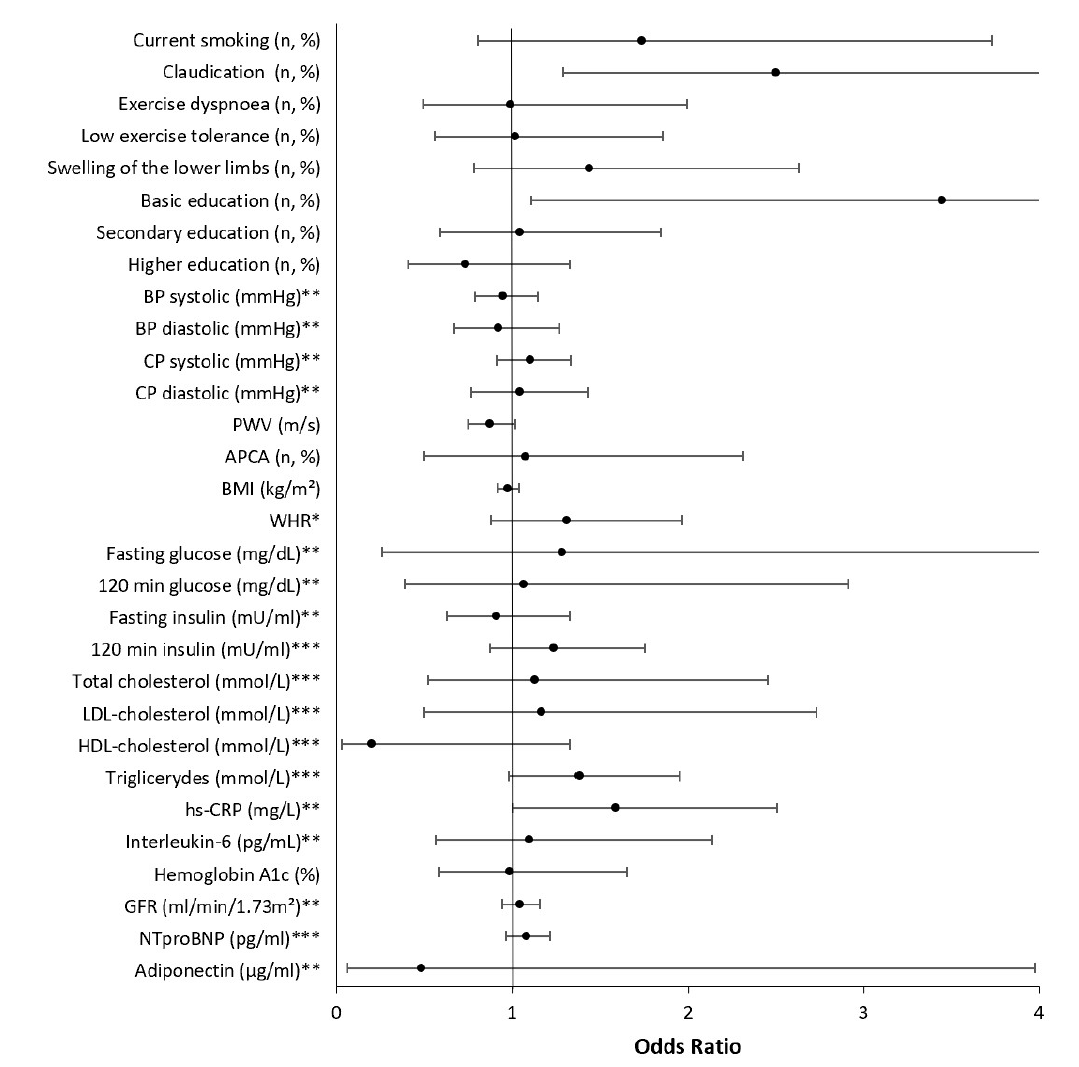
Figure 4. Multivariable predictors of an ABI ≤ 0.9 adjusted for age, gender, hypercholesterolemia, diabetes, hypertension, history of myocardial infarction, and stroke. * Per 0.1 units; ** per 10 units; *** per 100 units. BP, blood pressure; CP, central pressure; PWV, pulse wave velocity; APCA, atherosclerotic plaques in carotid arteries; IMT, intima-media thickness; BMI, body mass index; WHR, waist-to-hip ratio; LDL, low-density lipoprotein; HDL, high-density lipoprotein; hs-CRP, high-sensitivity C-reactive protein; GFR, glomerular filtration rate; NTproBNP, n-terminal pro-brain natriuretic peptide.